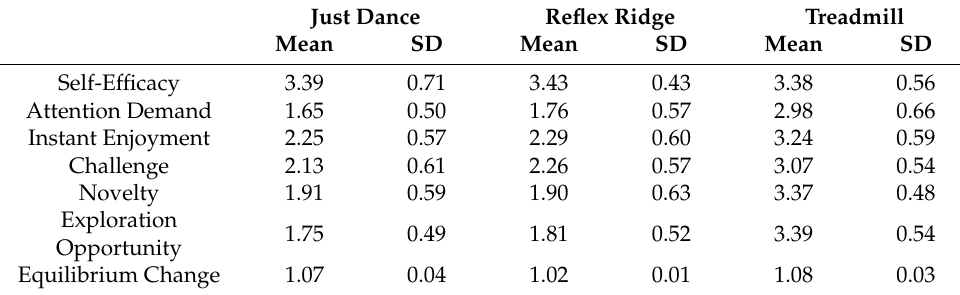
Table 1. Descriptive characteristics of the outcome variables. Just Dance Reflex